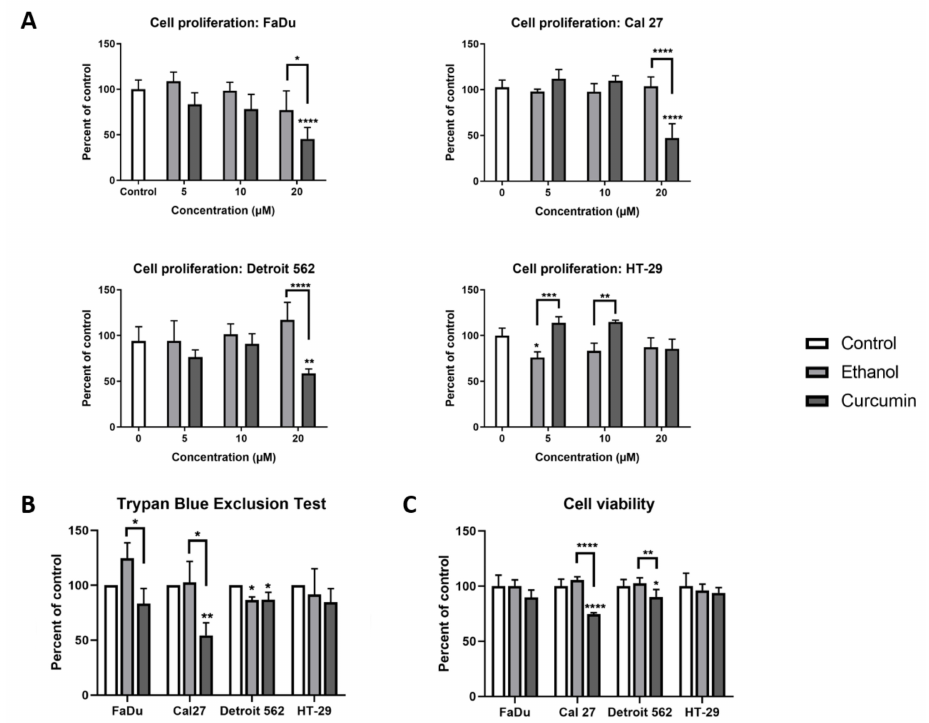
Figure 1. The e ff ect of curcumin on cellular behaviour is cell-type specific. ( A ) Cell proliferation—BrDu assay with three di ff erent curcumin concentrations; ( B ) Trypan Blue Exclusion Test; ( C ) Cell Viability–MTT assay with 20 µ M curcumin. One-way ANOVA with Tukey post-hoc test. * p < 0.05; ** p < 0.01; *** p < 0.001; **** p < 0.0001.